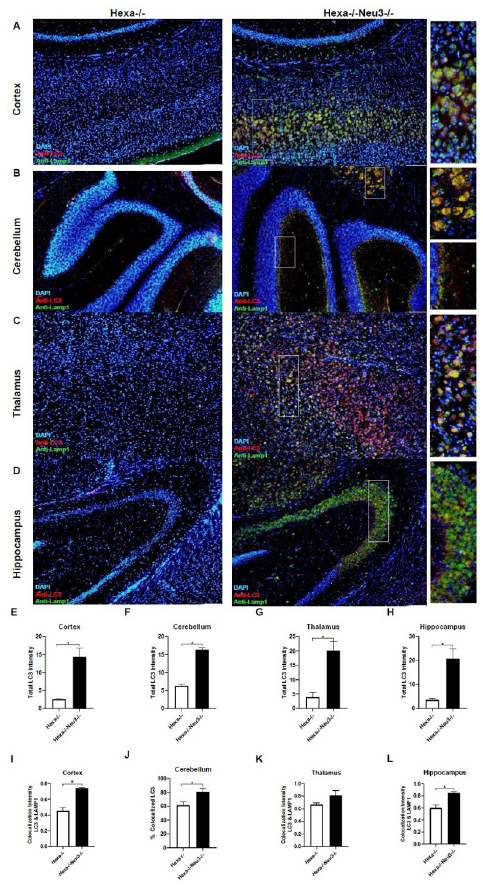
Fig 5. Immunohistochemical colocalization analysis images for cortex (A), cerebellum (B), thalamus (C), and hippocampus (D) sections from 5 months old Hexa-/- and Hexa-/-Neu3-/- mice. The sections were stained with anti- LC3 antibody (red; Autophagosome marker), anti-Lamp1 (green; lysosomal marker), and DAPI (blue; nucleus). Total LC3 intensity was represented for cortex (E), cerebellum (F), thalamus (G), and hippocampus (H). A yellow signal signifies the colocalization of LC3 and Lamp1 as autophagolysosomes. Colocalization percentages LC3 to Lamp1 were represented for cortex (I), cerebellum (J), thalamus (K), and hippocampus (L) Scale bar = 20 μ m. The data are represented as the mean ± S.E.M. Unpaired t-test was used for statistical analysis. ( � p < 0.05, �� p < 0.025, ��� p < 0.01 and ���� p < 0.001).